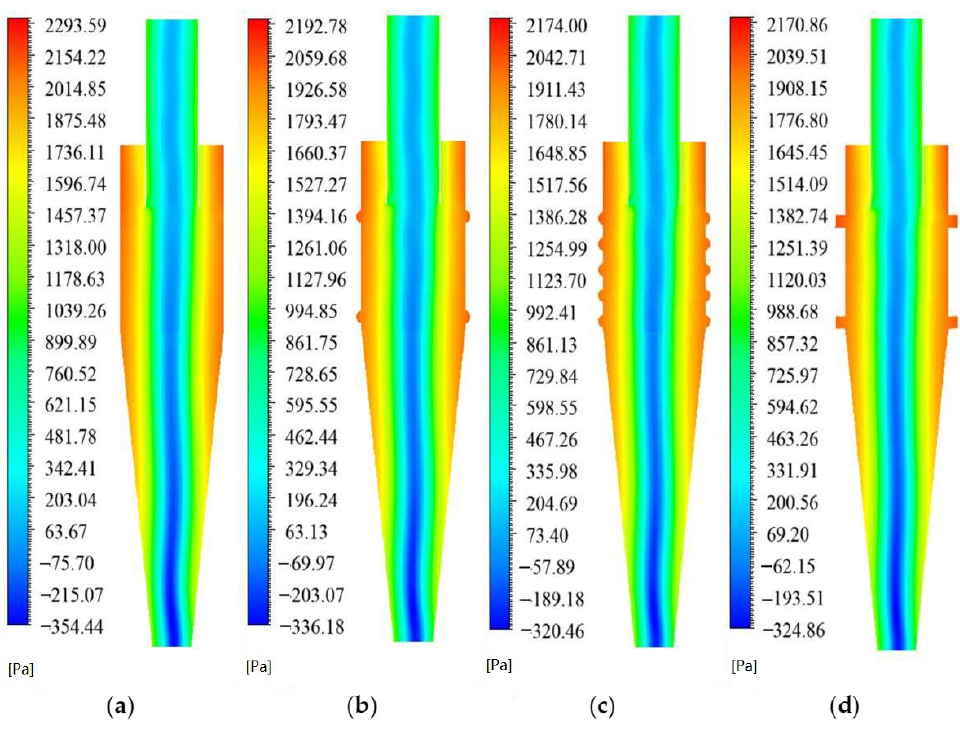
Figure 10. Contour plots of static pressure of cyclone models; ( a ) Model A (Stairmand cyclone separator), ( b ) Model B cyclone separator, ( c ) Model C cyclone separator, ( d ) Model D cyclone separator.